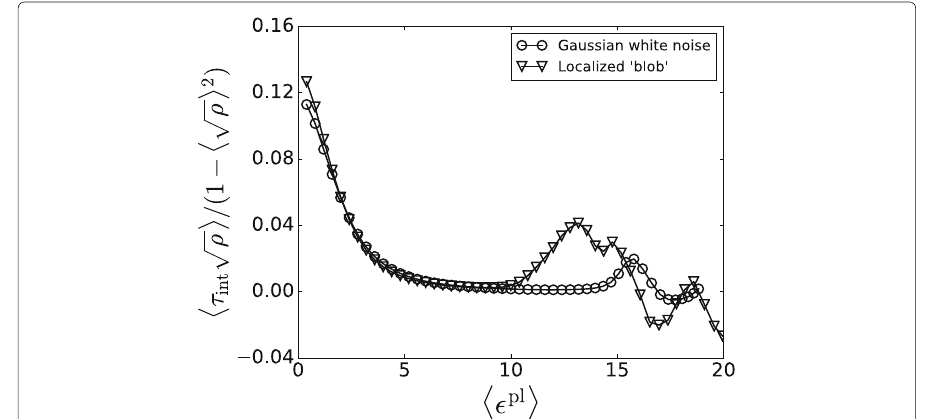
Fig. 6 Strain evolution of the correlation between internal stress and local flow stress, normalized by the scatter of local flow stresses; parameters as in Fig. 1